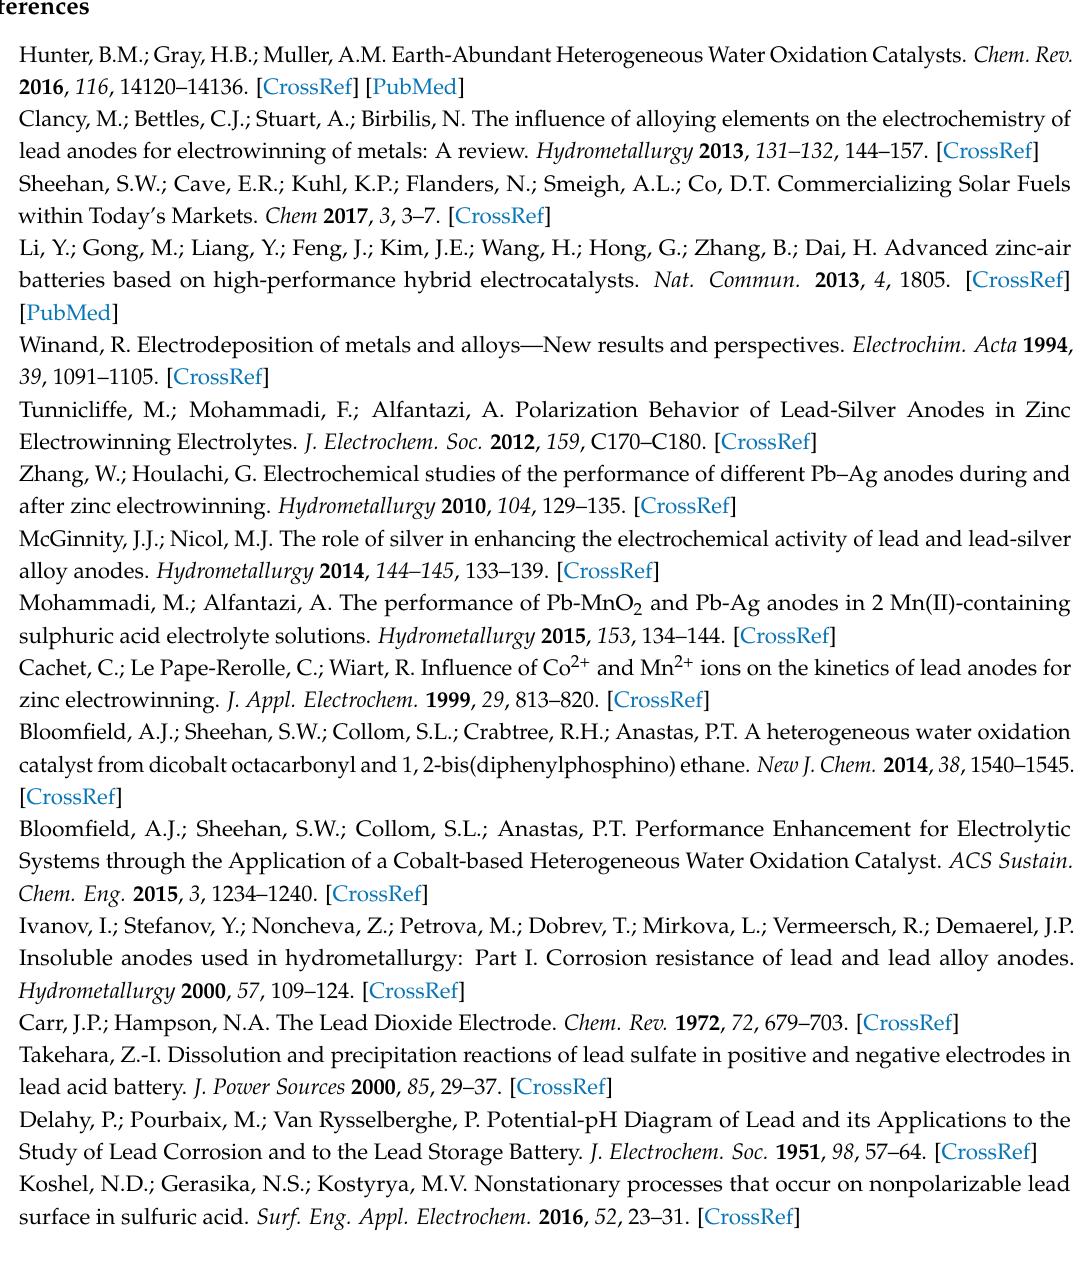
Figure S1: Exemplary Linear Sweep Voltammograms, Table S1: Exchange Current